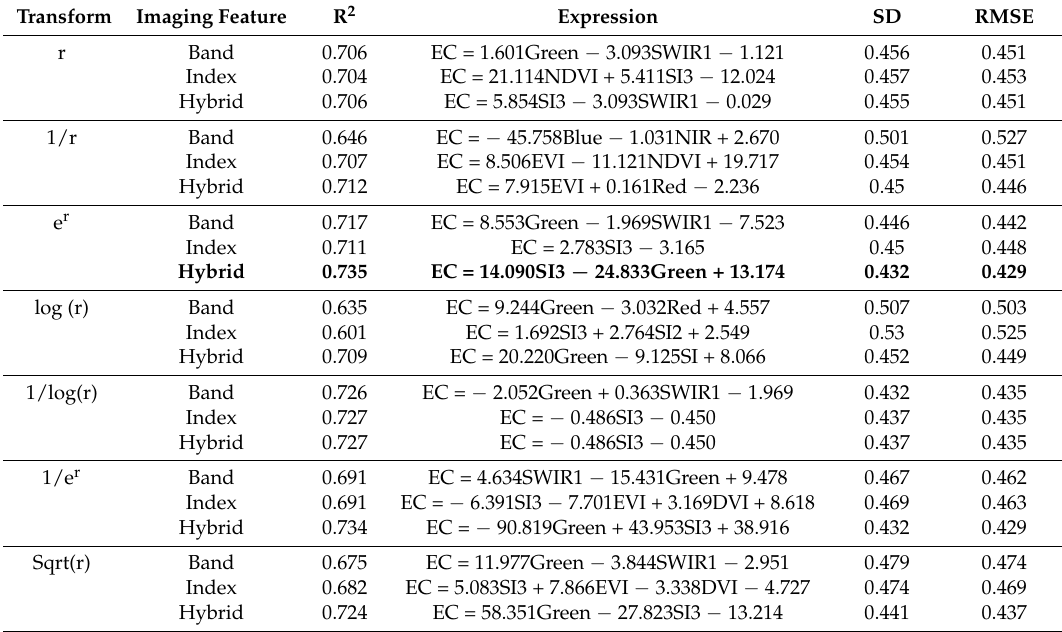
Table 4. The regression models for soil EC in relation to bands, spectral indices and hybrid variables. Transform Imaging Feature